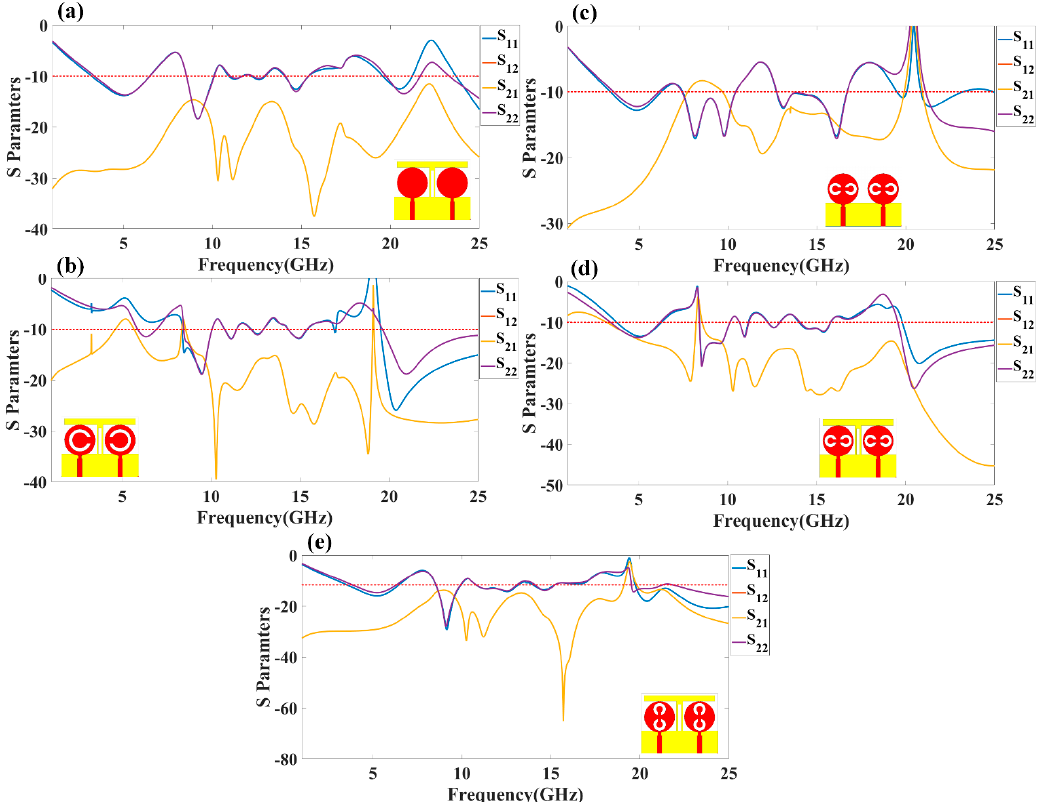
Figure 3. Calculated reflectance loss factors (S 11 , S 12 , S 21 , and S 22 ) (in dB) for ( a ) design 1, ( b ) design 2, ( c ) design 3, ( d ) design 4, and ( e ) design 5 of the proposed structure of the antenna.